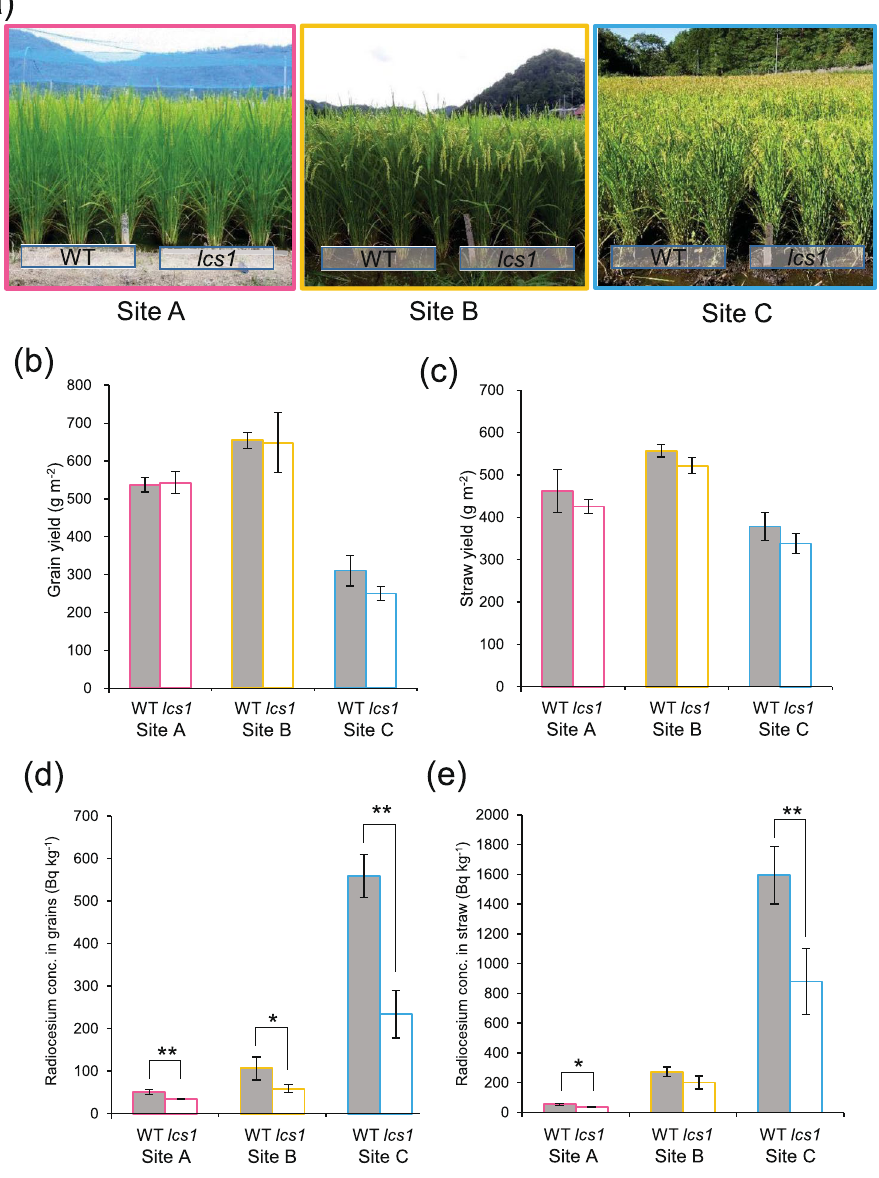
Figure 1. Plant morphology, grain yield, straw yield, and total radiocesium (sum of 134 Cs and 137 Cs) in wild- type Koshihikari and its low-cesium mutant ( lcs1 ) grown in three paddy fields located in Fukushima Prefecture. ( a ) Morphology of WT and lcs1 plants grown in three fields (sites A, B, and C). ( b ) Grain yield. ( c ) Straw yield. ( d ) Total radiocesium concentration in grains (unpolished rice). ( e ) Total radiocesium concentration in straw. Data are means ± SD of three biological replicates. ** P < 0.01, * P < 0.05 ( t